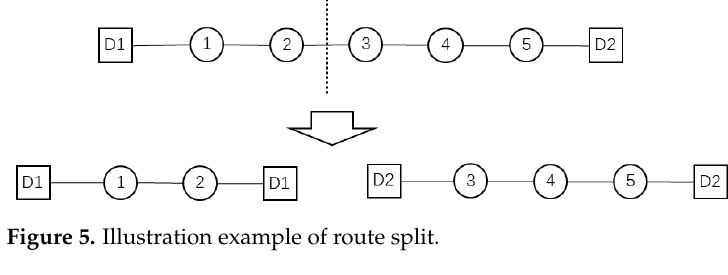
Figure 5. Illustration example of route split.